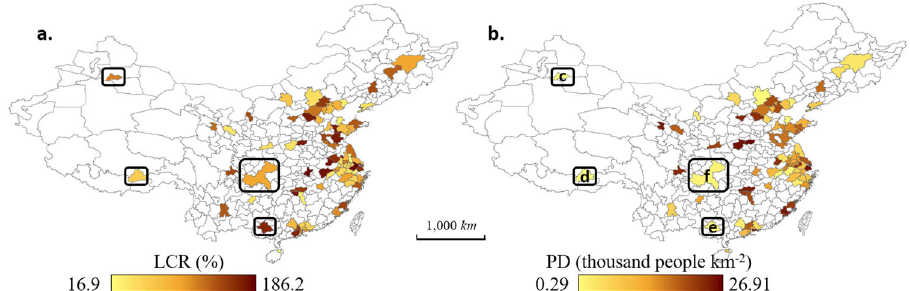
Fig. 6 Comparison between land carrying rate (LCR) and population density (PD), highlighting the differences between underload and ghost cities. a , b LCR and PD of 81 cities. c – f Urumqi, Lhasa, Nanning, and Chongqing which are identi fi ed as ghost cities according to PD but nonunderload by